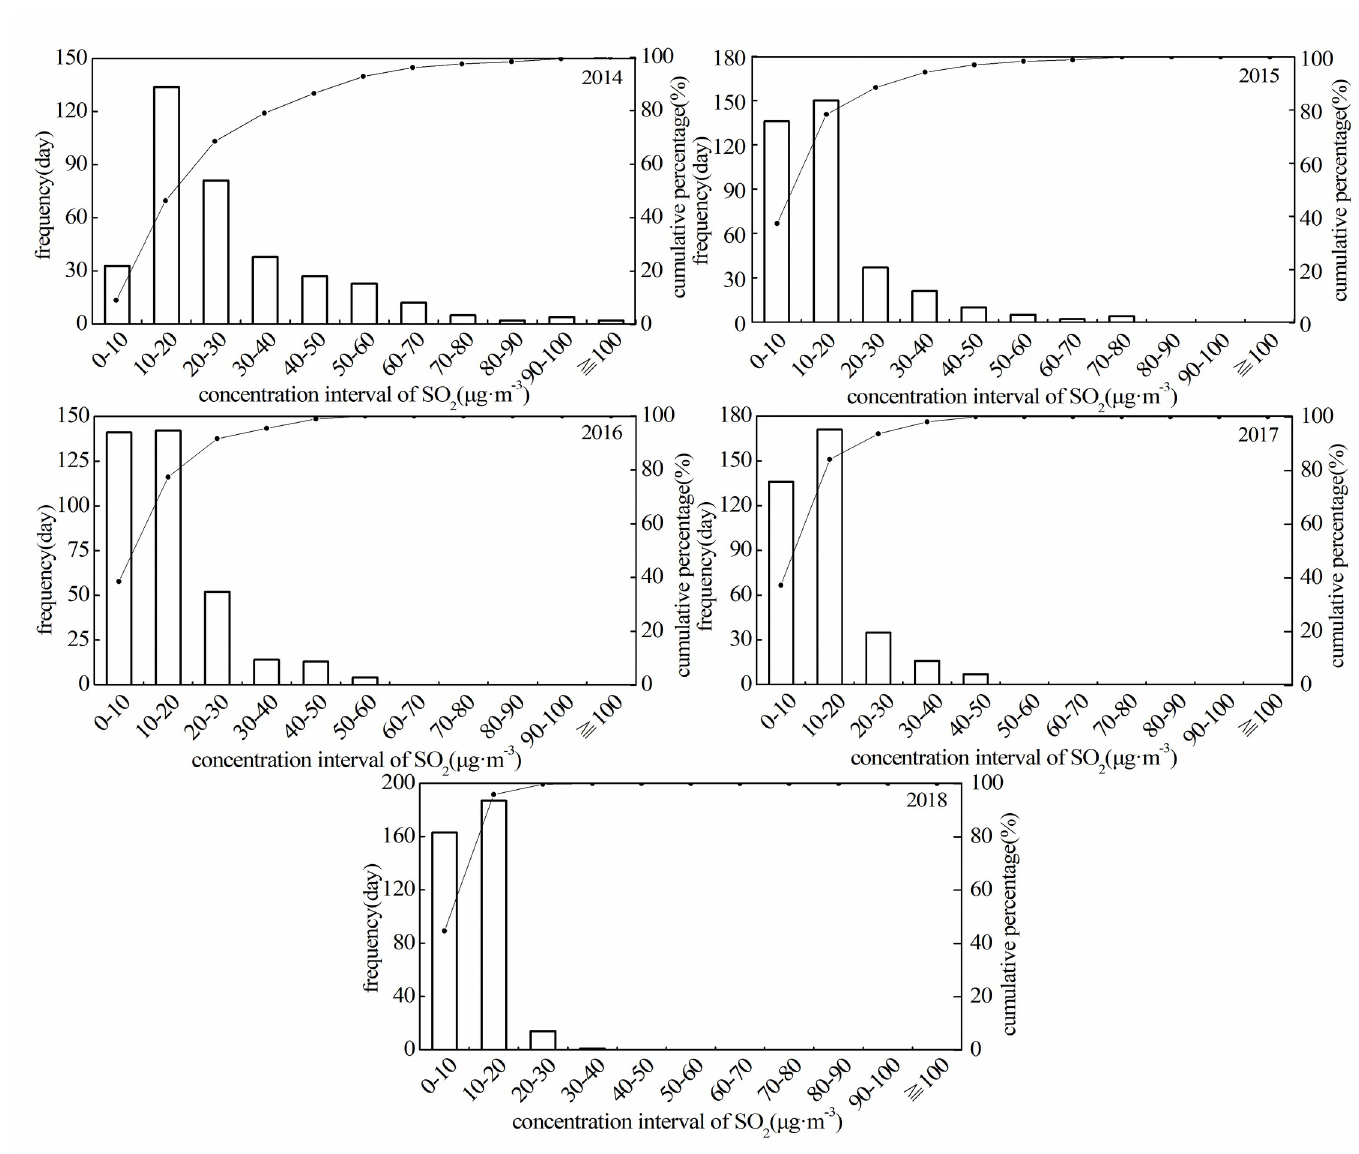
Fig 4. Histogram of daily SO 2 concentration distribution in